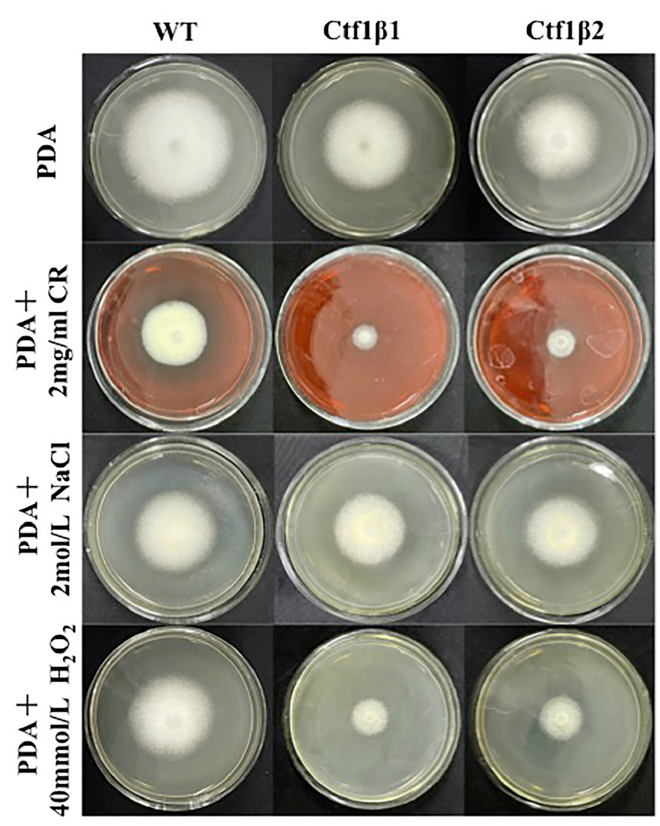
Figure 11. Comparison of the colony morphology and stress tolerance of wild-type, Δ Ap Ctf1 β 1 and Δ Ap Ctf1 β 2 strains. Note: The wild-type, Ctf1 β 1 deletion and Ctf1 β 2 deletion strains were inoculated on PDA media or PDA media appended with various stressors and cultured at 25 °C in darkness for 5 days.